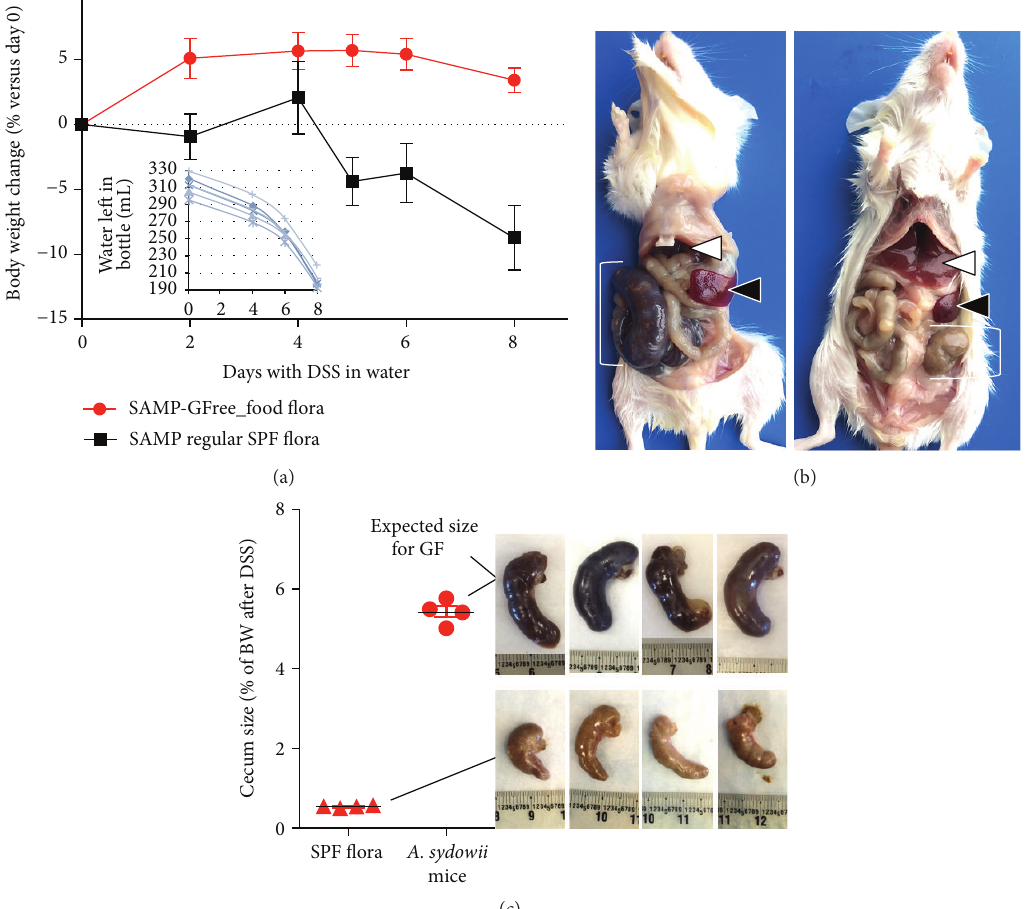
Figure 4: DSS treatment did not induce typical signs of DSS colitis in contaminated mice. (a) Body weight of mice (8 weeks old) contaminated with A. sydowii did not lose weight compared to mice harboring regular mouse SPF microbiota ( 𝑛 = 4 /group, 2/cage). Inset plot: water content ineachcagewaterbottleindicatesthatallmiceconsumedthesameamountofDSSsupplementedwater.(b)PostmortemafterDSSexperiment. Note the small liver and large spleen and cecum (left) in A. sydowii mice as it is expected in mice in GF conditions. (c) Note the expected reduction in cecum size in SPF mice after DSS treatment due to diarrhea and appetite